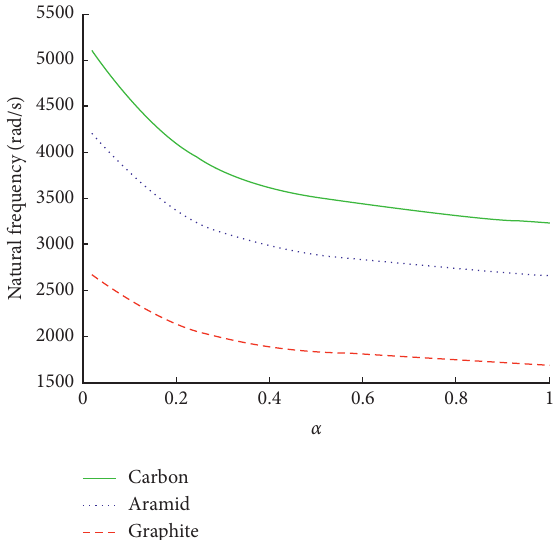
Figure 6: Natural frequency of the tapered composite boring bar with different composite material.